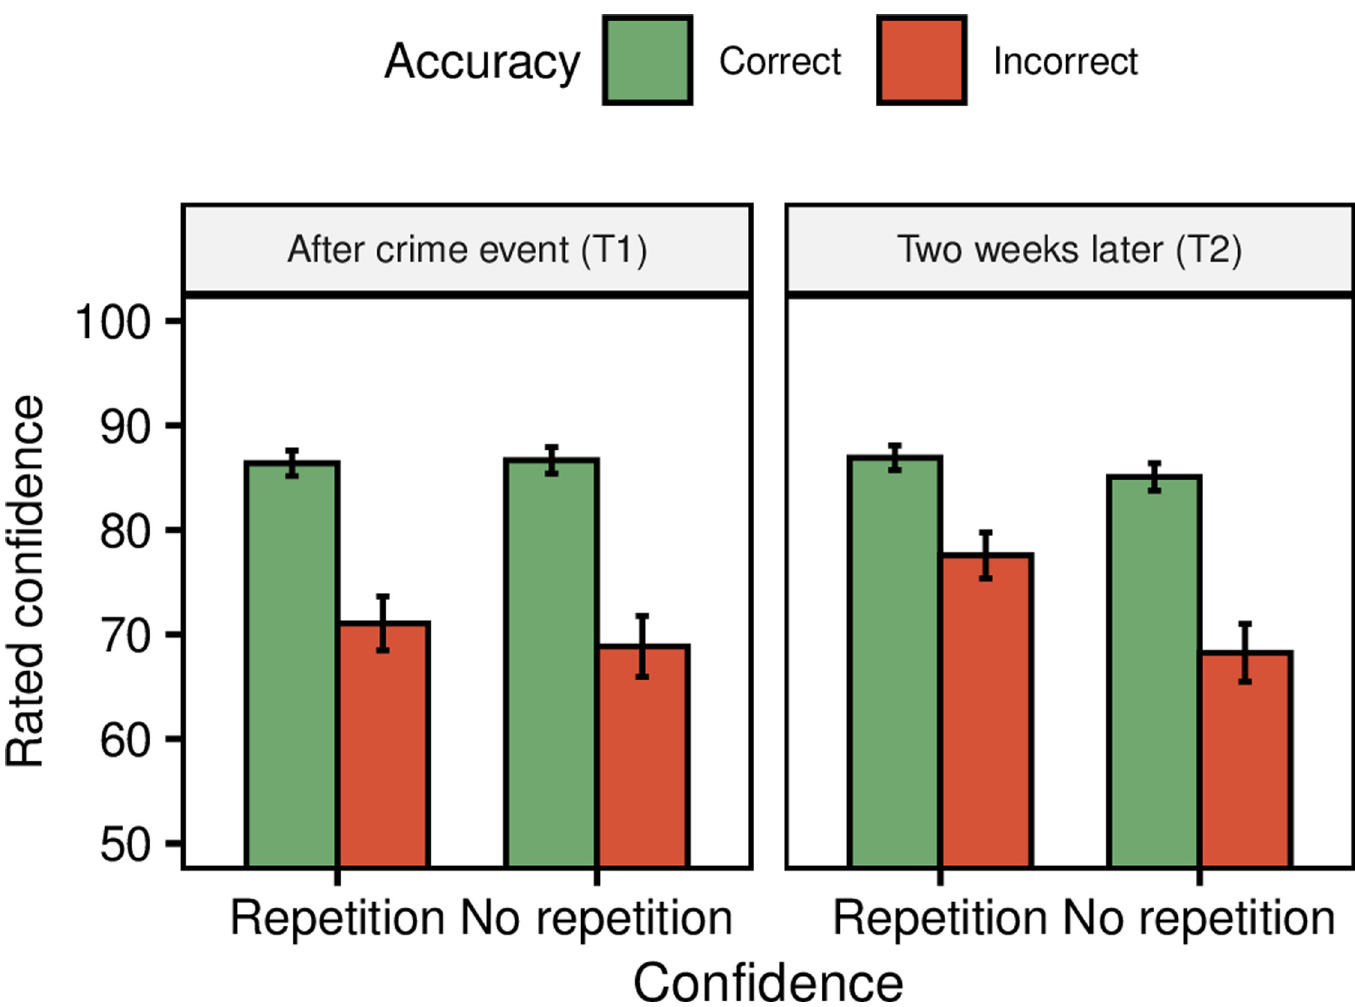
Fig 3. Effects of accuracy, time and repetition on confidence. Note. Error bars represent 95% confidence intervals.